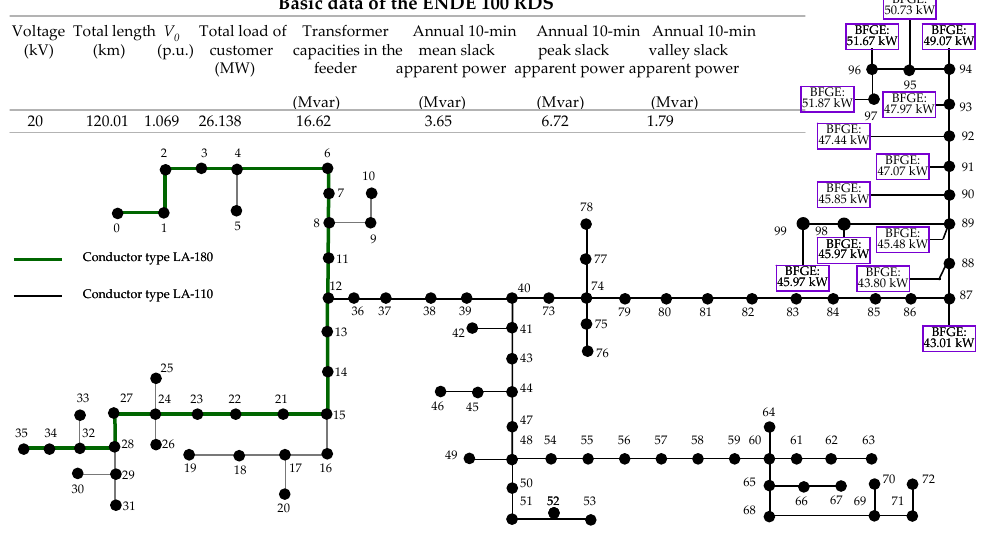
Figure 3. Single-phase diagram of the ENDE 100 RDS.